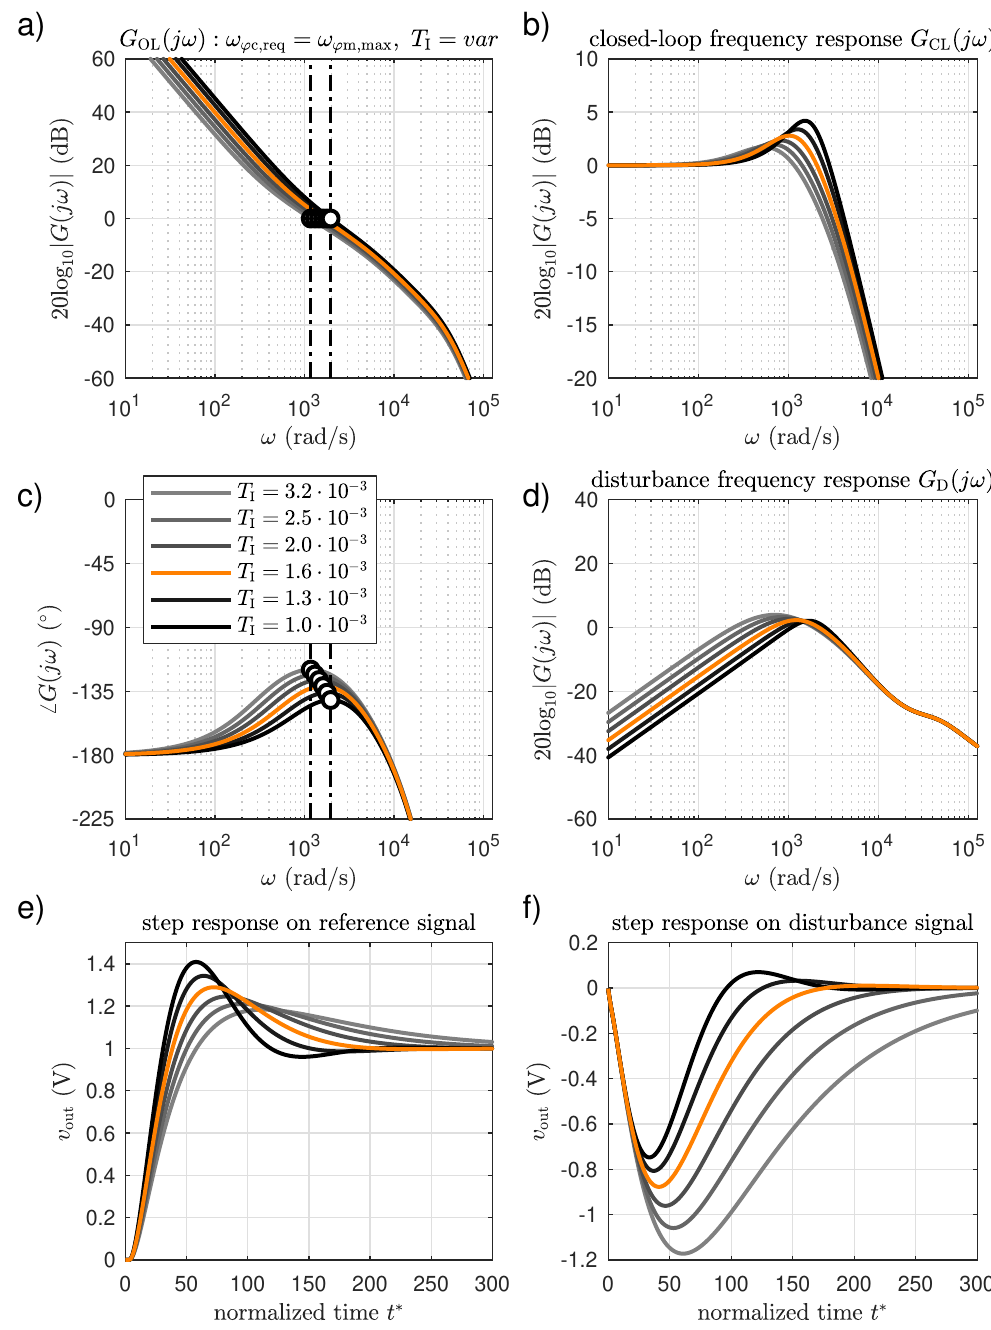
Figure 12. The voltage control loop characteristics for various integral time T I values between 1.0 × 10 − 3 s and 3.2 × 10 − 3 s and for proportional gain k P calculated to maximize the open-loop system phase margin: ( a , c ) amplitude and phase Bode plots of the open-loop system frequency response, ( b ) amplitude Bode plot of the closed-loop system frequency response, ( d ) amplitude Bode plot of the disturbance frequency response of the system, ( e ) response of the system on a unit step of the reference signal, ( f ) response of the system on a unit step of the disturbance